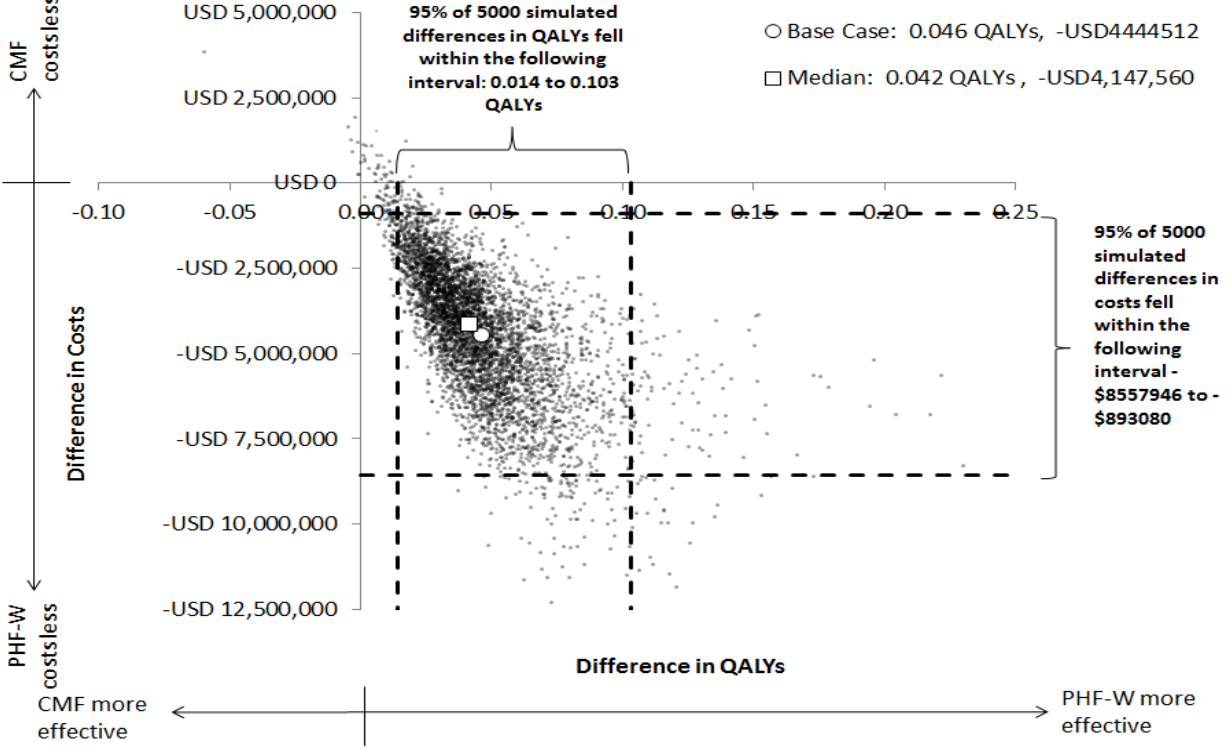
Figure 2. Scatterplot of Difference in Costs and QALYs Resulting from Multivariate PSA Each black dot represents 1 of the 5000 multivariate PSA